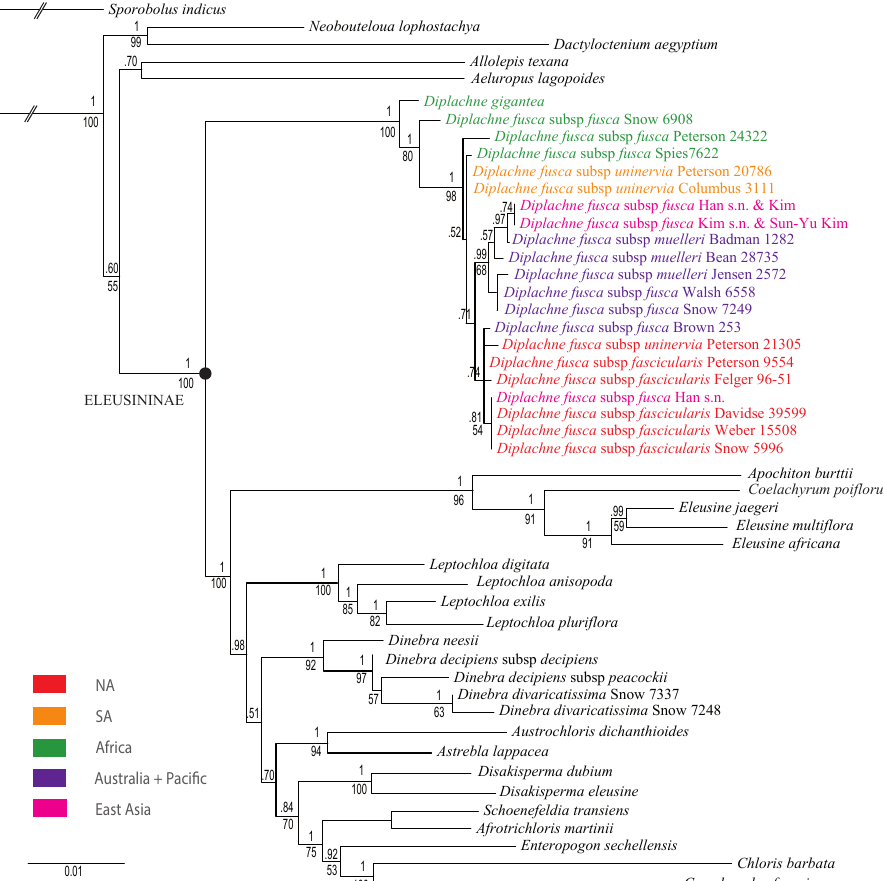
Figure 1. Maximum likelihood tree inferred from nuclear analysis of combined plastid ( rpL32-trnL, ndh A intron, rps16 intron, and rps16-trnK ) and ITS sequences. Numbers above branches are bootstrap values; numbers below branches are posterior probabilities from Bayesian analysis; color indicates native distribution (see legend) of Diplachne species. Scale bar: substitutions per